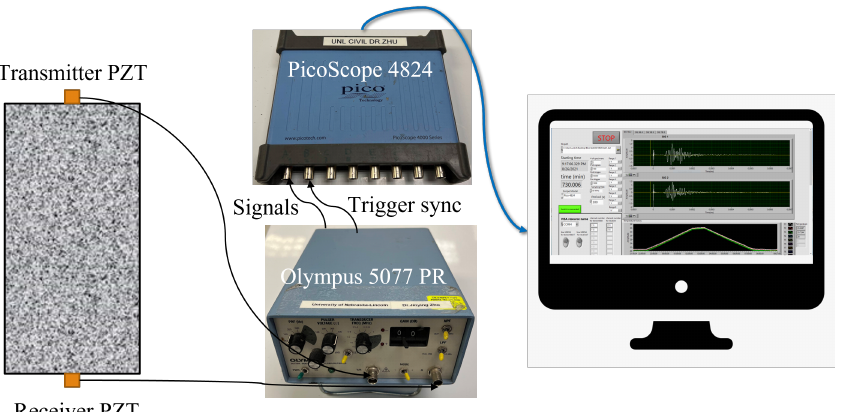
Figure 2. Schematic diagram illustrating the experimental setup for ultrasonic monitoring in all experiments. Additional sensors (thermocouple or load cell) were added in the temperature change and uni-axial loading test.